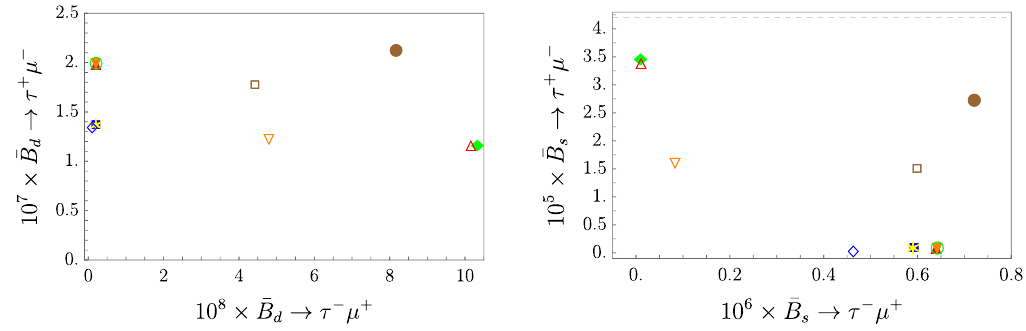
Figure 2 . Correlation between the (cid:22) B d;s ! (cid:28) (cid:0) (cid:22) + and (cid:22) B d;s ! (cid:28) + (cid:22) (cid:0) modes for each scenario. The di(cid:11)erent solutions are labeled as in (cid:12)gure 1. On the left panel, the experimental limit is at O (10 (cid:0) 6 ) and accordingly is not displayed. On the right panel, the grey dashed line is the current LHCb upper limit [62]. This includes both (cid:22) B s ! (cid:28) (cid:0) (cid:22) + and (cid:22) B s ! (cid:28) + (cid:22) (cid:0) modes, so what is shown is a conservative upper